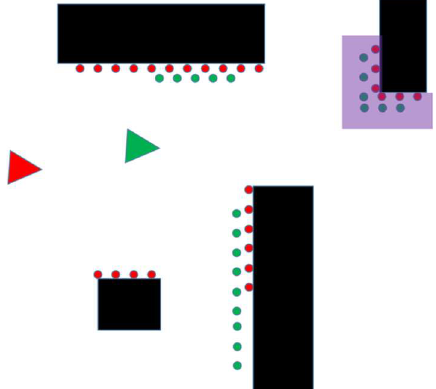
Figure 3. Data association in the attention area of the current frame. Red is the reference frame, green is the current frame, and the purple area is the attention area.